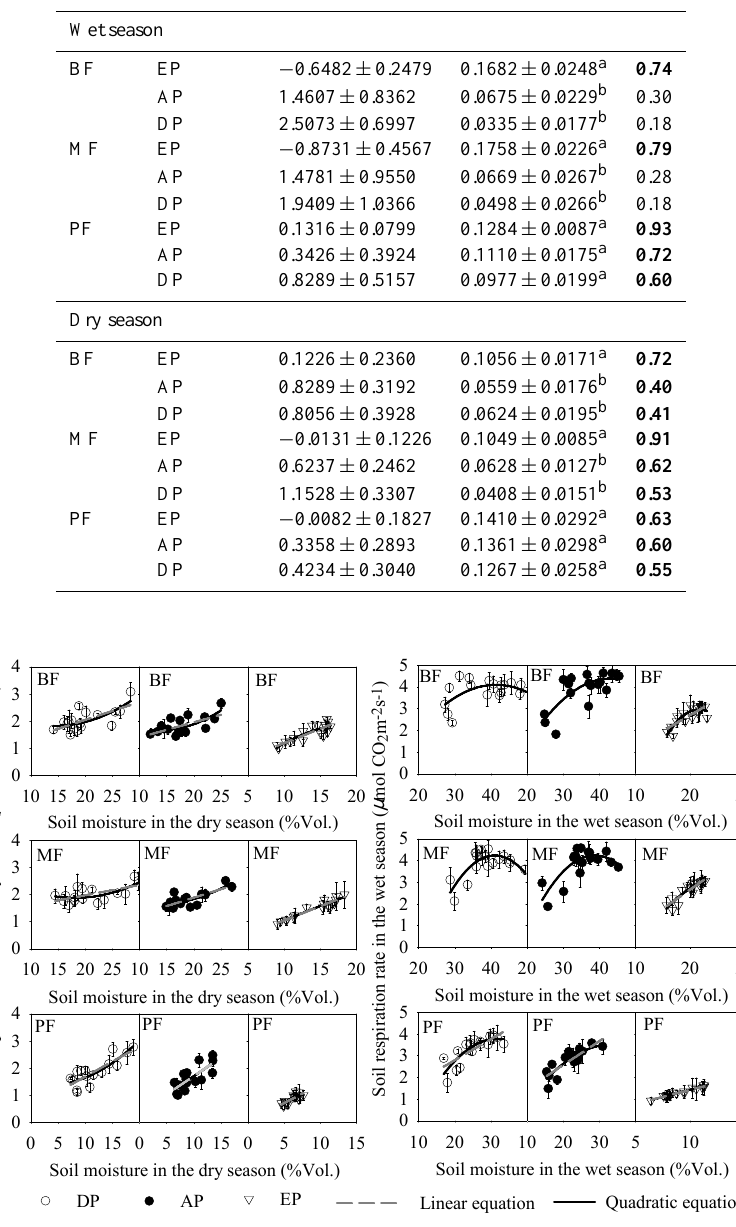
Fig. A2. Relationships of soil respiration rate ( R , µmolCO 2 m − 2 s − 1 ) and soil moisture of the top 5cm soil layer ( M , %vol.) (linear regres- sion equation: R = a + cM and quadratic equation: R = a 0 M 2 + c 0 M + d 0 ) under different seasons and different precipitation treatments at the DNR forests. The treatments are as follows: precipitation exclusion (EP), ambient precipitation (AP), and double precipitation (DP). The forests are as follows: broadleaf forest (BF), mixed forest (MF), and pine forest (PF). The equations are listed in Tables A2 and